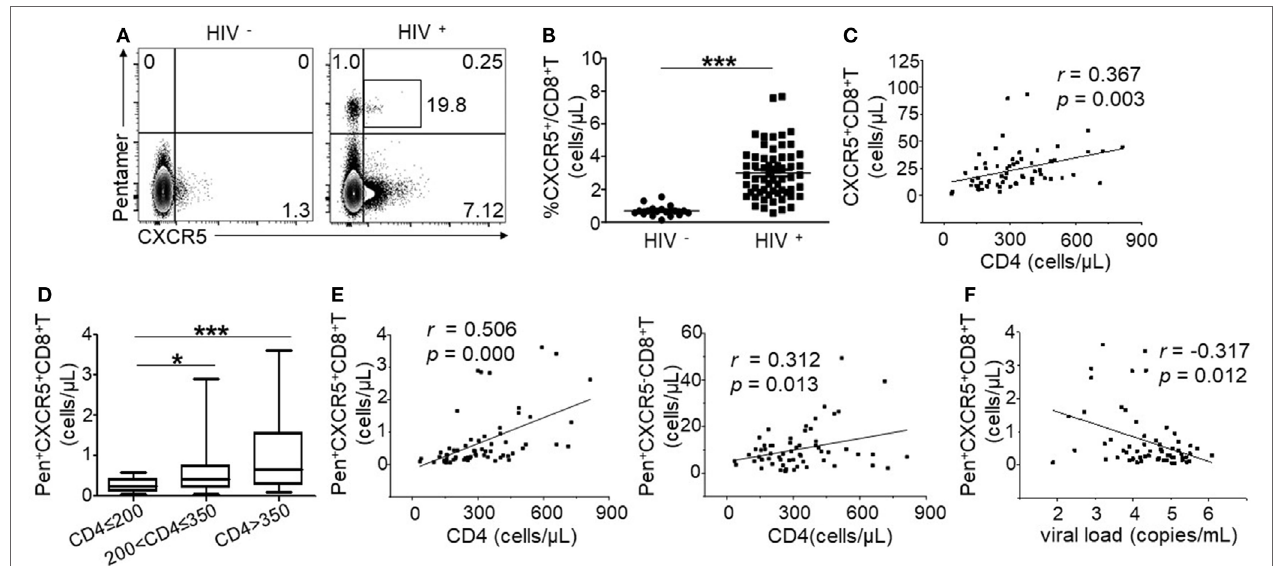
FigUre 1 | HIV-specific CXCR5 + CD8 + T cells are negatively correlated with disease progression during chronic HIV infection. (a) Representative flow cytometric data of CXCR5 and Pentamer staining from the peripheral blood of healthy controls and HIV-infected patients (gated on CD3 + CD8 + lymphocytes). The values in the quadrant represent the frequency of individual populations. The number in the box represents the frequency of CXCR5 + expression among the Pentamer + population. (B) Comparison of the percentage of CXCR5 + CD8 + T cells between the healthy controls and typical progressers. (c) Positive correlation between peripheral CXCR5 + CD8 + T cells and CD4 + T cell counts ( p = 0.003). (D) Statistical analysis of the number of CD3 + CD8 + Pentamer + CXCR5 + T cells in individual groups with different CD4 + T cell numbers. Multiple comparisons between the different groups were made using a Kruskal–Wallis H non-parametric test (* p < 0.05, *** p < 0.001). (e) Positive correlation between the number of CD3 + CD8 + Pentamer + CXCR5 + T cells (left, p = 0.0001), CD3 + CD8 + Pentamer + CXCR5 − T cells (right, p = 0.0013) and CD4 + T cell counts. (F) Negative correlation between the absolute cell number of CD3 + CD8 + Pentamer + CXCR5 + T cells and plasma viral load. Each dot represents one individual. The correlation analysis was evaluated via a Spearman rank correlation test. Solid line, linear growth trend; r , correlative coefficient. p values are